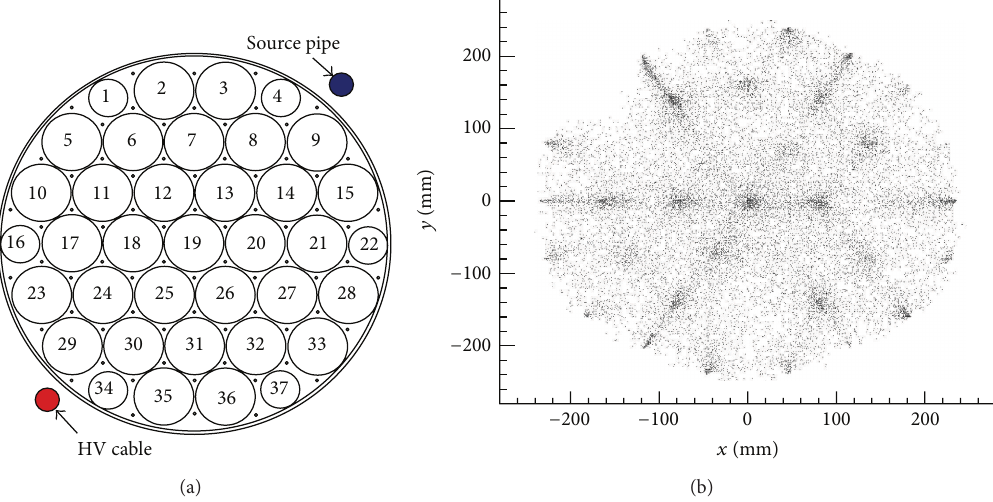
Figure 10: Reconstructed positions of 25000 events from the 2011 WArP run (b), to be compared with the actual PMT disposition (a). Nonworking PMTs are numbers 5, 11, 26, 31, and